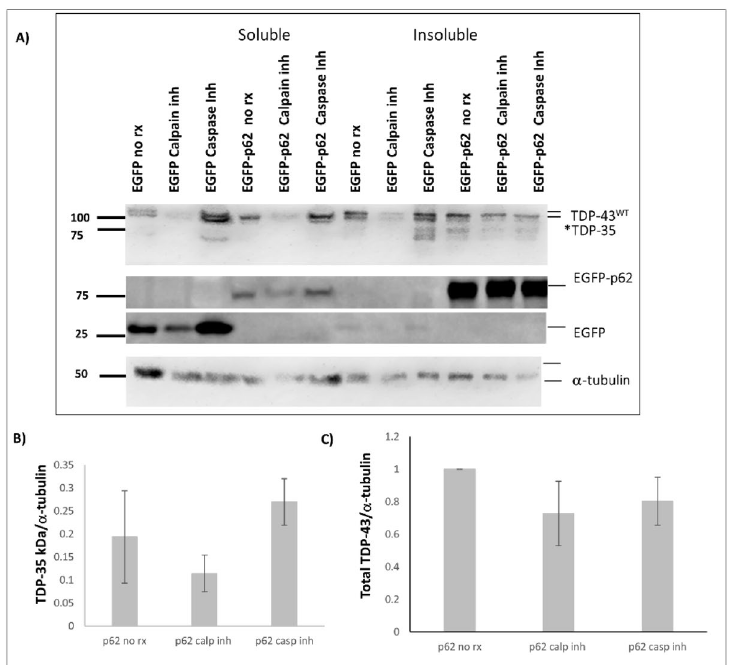
Figure 7. p62-mediated cleavage of TDP-43 is independent of caspases. NSC-34 cells were pre-treated with 20 μM caspase inhibitor, 5 μM calpain inhibitor or were left untreated for 1 h and then transfected with TDP- 43-tdTomato and either EGFP or EGFP-p62. Cells were maintained in media containing the inhibitor for 48 h and then harvested for soluble and insoluble fractions. Western blot analyses for TDP-43 (anti-RFP), EGFP and α-tubulin were performed. TDP-43 bands were quantified using ImageJ and the amount of TDP-35-tdTomato fragment observed in the insoluble fraction of EGFP versus EGFP-p62 expressing cells was compared with